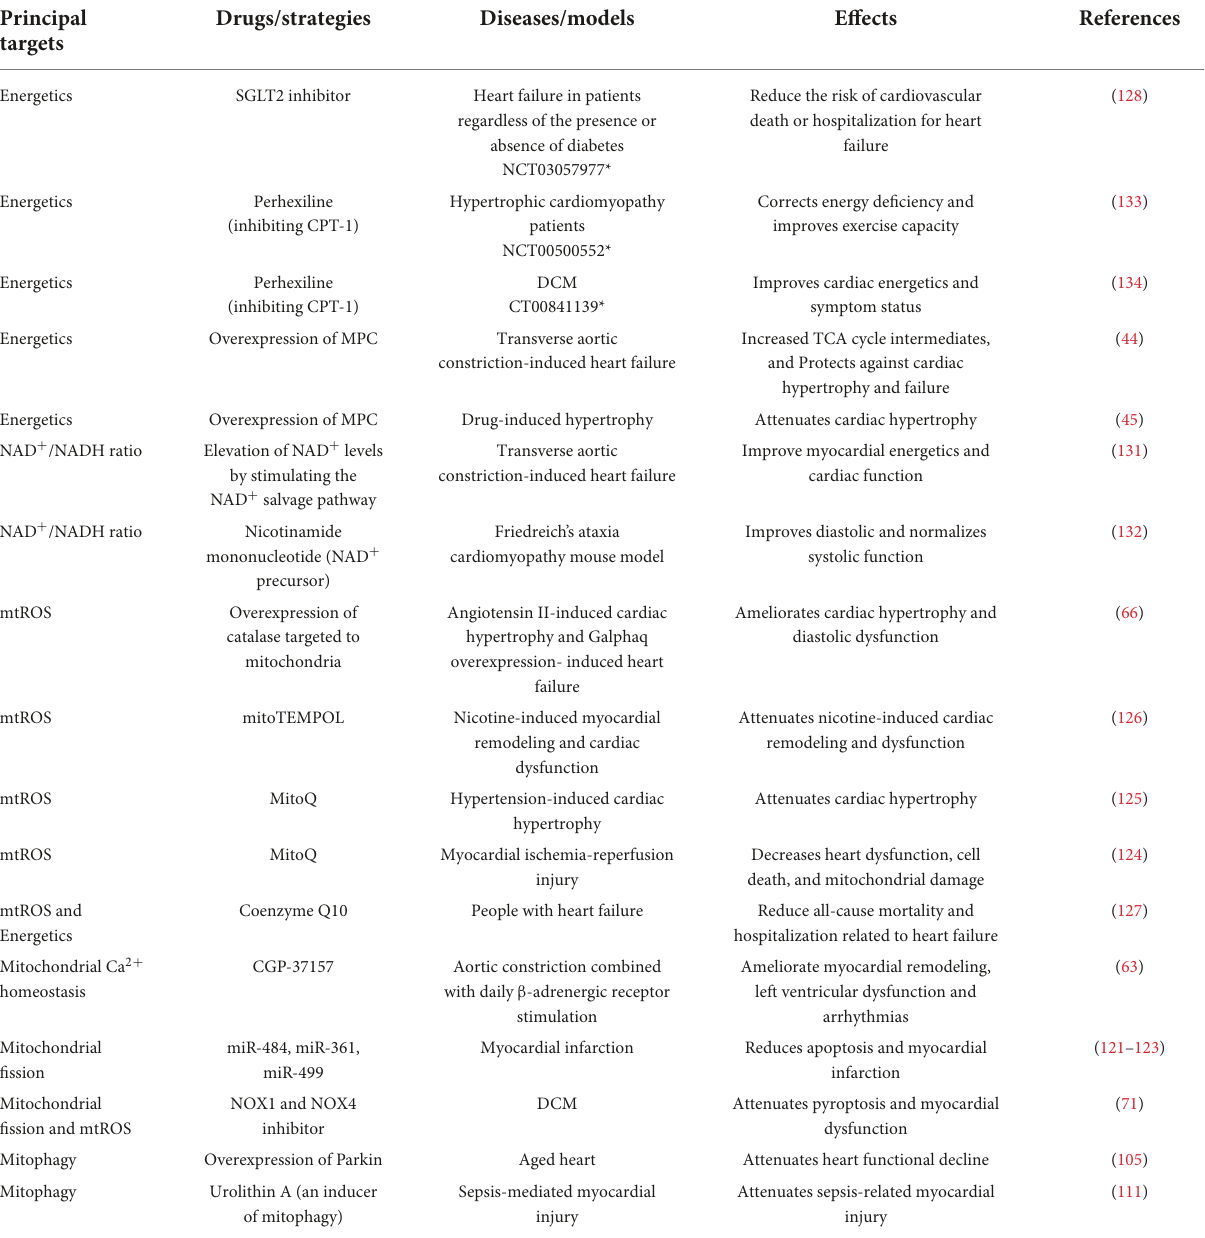
TABLE 1 Therapeutic strategies targeting mitochondria for treatment of heart